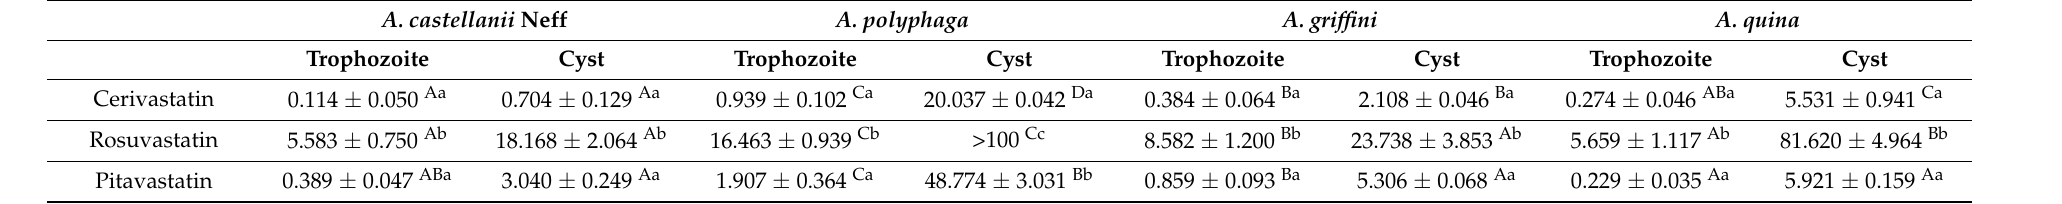
Table 1. Amoebicidal activity of the three statins against both cysts and trophozoites of Acanthamoeba spp. IC 50 ( µ